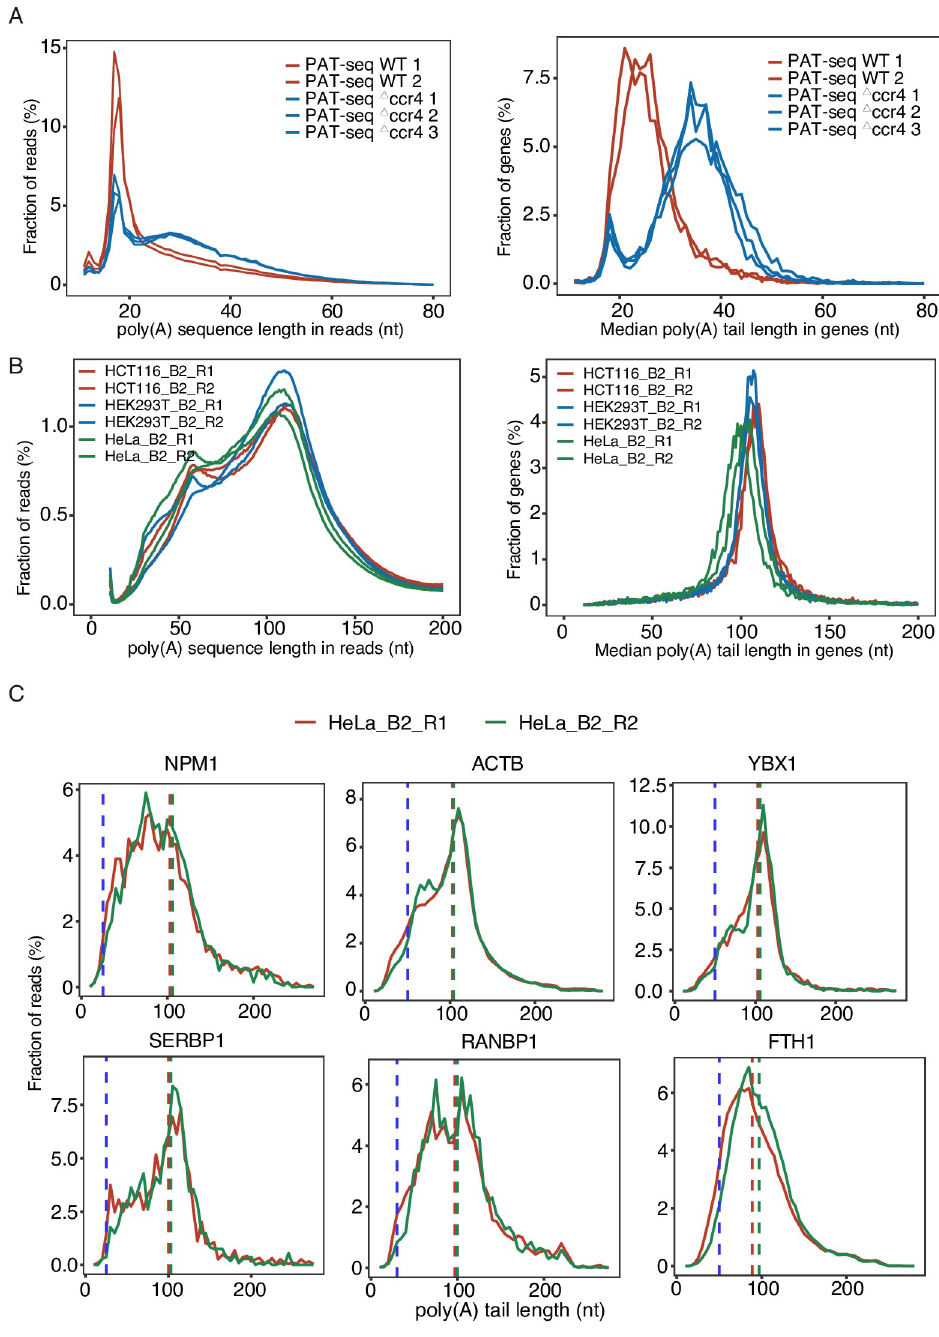
Fig 3. The length profiles of poly(A) sequence in Poly(A)-seq reads and of median poly(A) tails in genes. A. The poly(A) tail length distribution in reads (left) and genes (right) in yeast, which is resulted from the analysis of PAT-seq data [21] by running pA-finder. B. The poly(A) tail length distribution in reads (left) and genes (right) in three human cell lines, which is resulted from the analysis of Poly(A)-seq data in this study by running pA-finder. C. Poly(A) tail profiles in poly(A)-containing reads of 6 human genes in HeLa cells. The blue dashed line indicates the poly(A) tail length detected by TAIL-seq [14]. The red and green dashed lines indicate the median poly(A) tail length of HeLa_B2_R1 and HeLa_B2_R2, respectively.